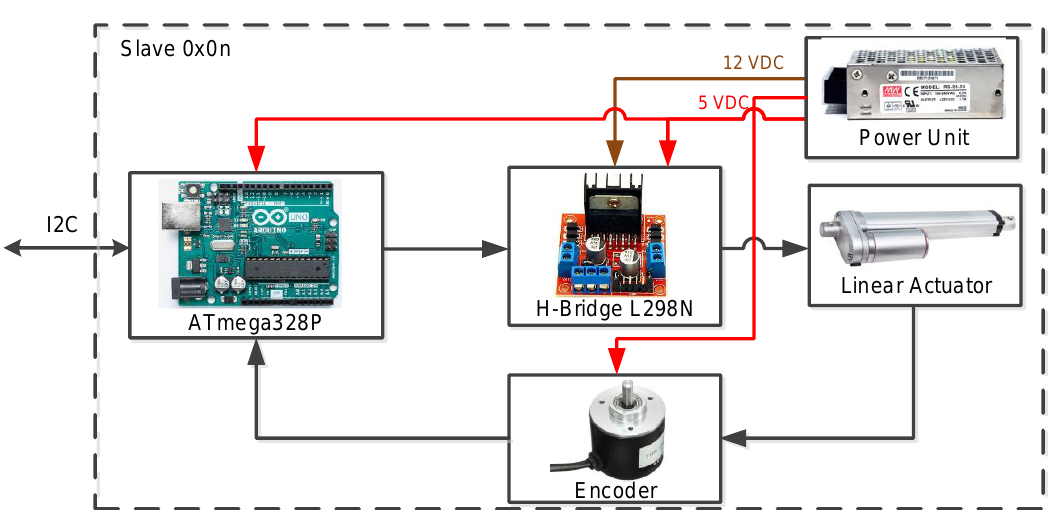
Figure 15. Electronic schematic of the master device.